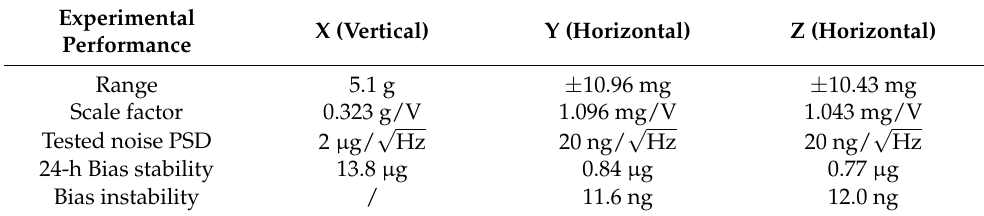
Table 2. Prototype’s performance